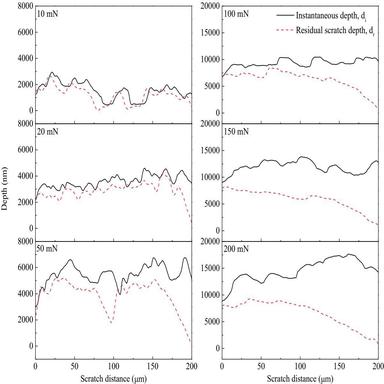
Instantaneous and residual depth profiles of the CL scratches with different pre-designed loading levels: 10, 20, 50, 100, 150 and 200 mN.